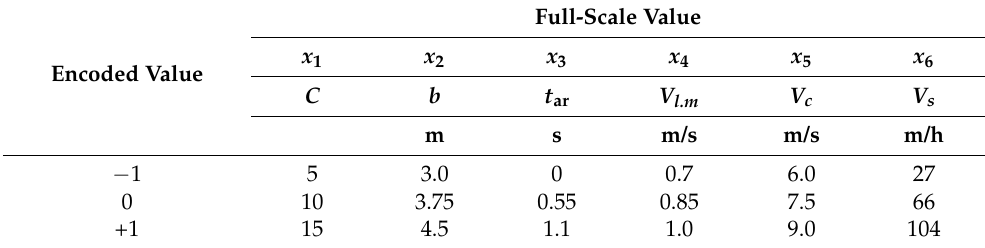
Table 1. Coding of variable factors.